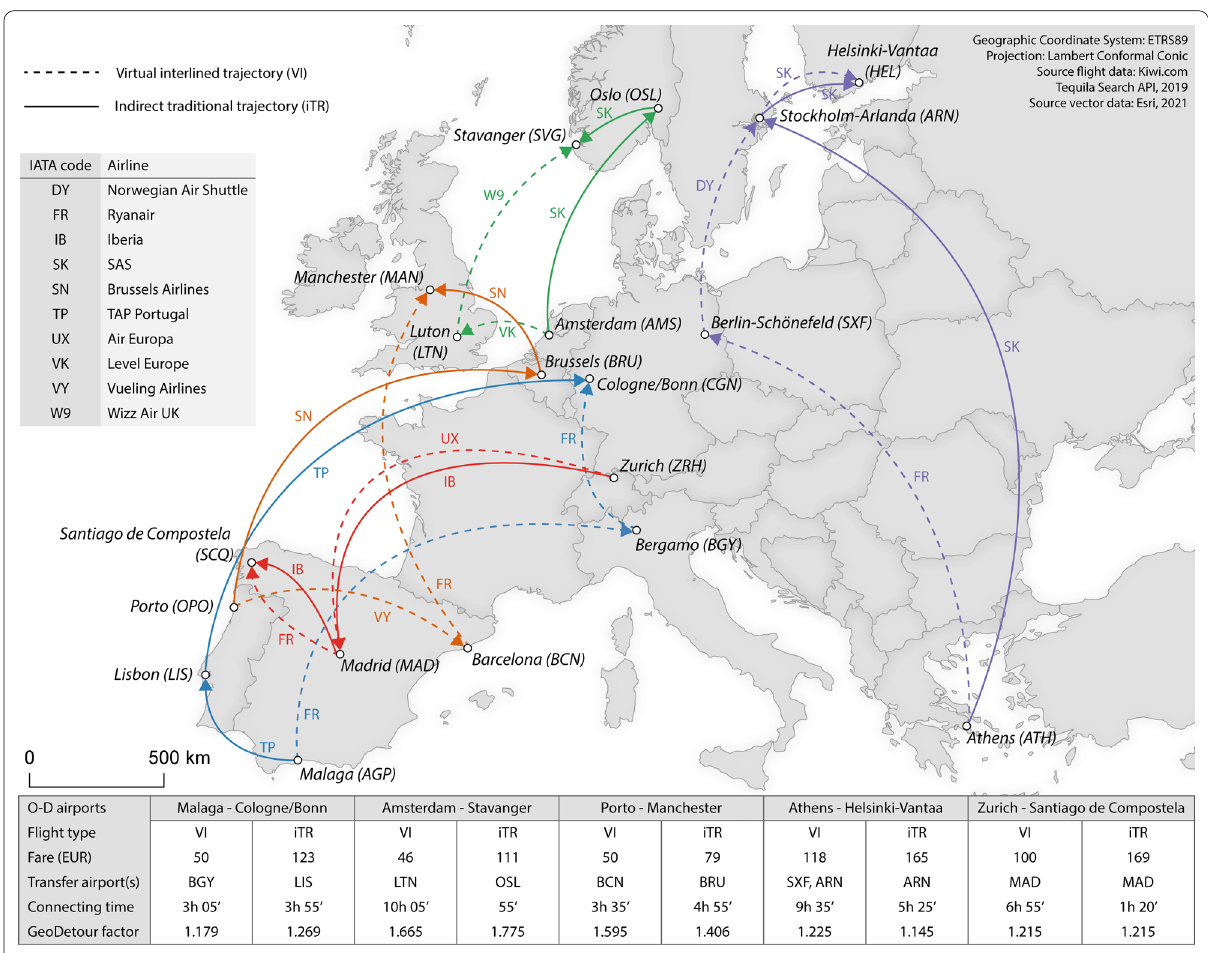
Fig. 2 Dataset examples (departure on 02 October 2019, data collection round b). The connection lines are for illustrative purposes only, and therefore do not correspond to the great circle